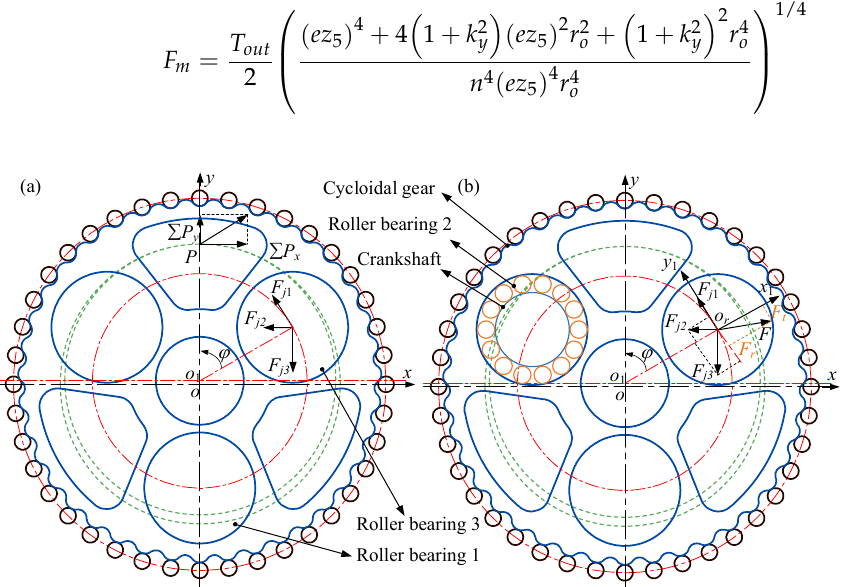
cylindrical roller bearings in the same cycloid gear are found to have a phase difference of 120 ◦ . According to Harris et al. [24], the equivalent load of cylindrical roller bearings can be calculated as [23]: